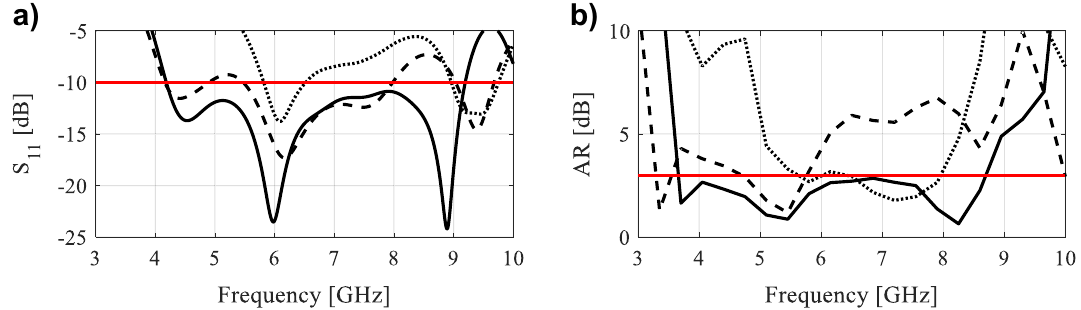
Figure 1. Rudimentary scaling of an exemplary wide-slot CP antenna: the design optimized for 4.2 GHz (solid line), antenna responses upon scaling to 3.7 GHz (dashed line), antenna responses upon scaling to 4.5 GHz (dotted line): ( a ) |S11|, ( b )